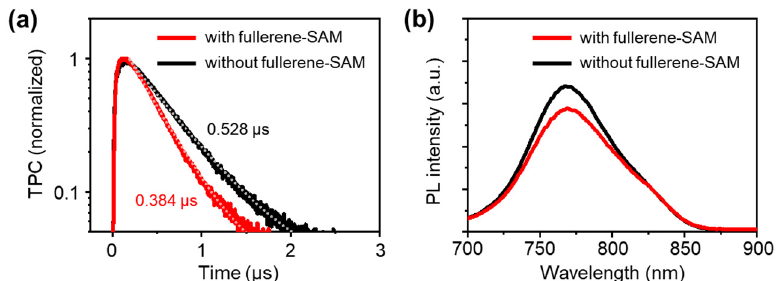
Figure 4. Characterization of changes in interfacial properties by fullerene-SAM treatment. ( a ) TPC decay profiles of solar cell devices. Solid lines: measured data points. Dotted lines: fitted lines (mono-exponential decay). ( b ) PL spectra of blend films on ZnO interlayer with and without SAM treatment. Excitation wavelength: 650 nm.